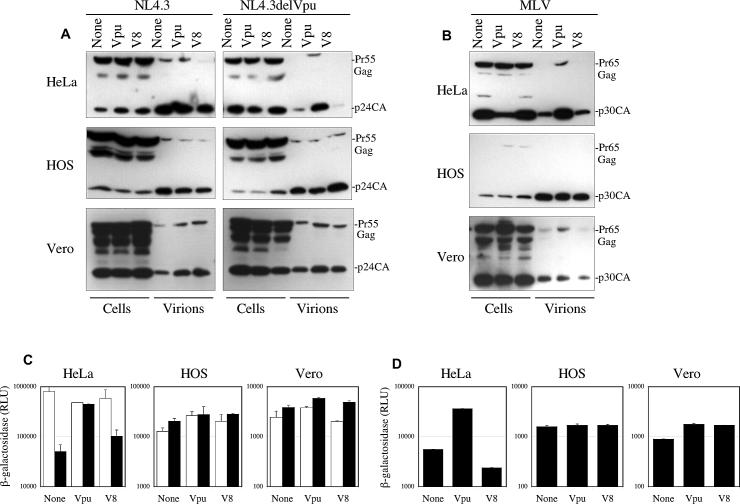
Cell Type–Dependent Effects of Vpu on Retroviral Particle ReleaseHuman HeLa and HOS cells, together with AGM Vero cells, were transfected with HIV-1 NL4.3 and NL4.3delVpu proviral plasmids, or an MLV Gag-Pol–expression vector, as indicated, in the presence of plasmids expressing either no Vpu (none), codon-optimized Vpu, or an inactive Vpu mutant containing a CD8 TM domain (V8).(A and B) Western blot analyses of cell and virion lysates, probed using antibodies to HIV-1 (A) or MLV CA (B).(C and D) Results of chemiluminsecent β-galactosidase assays following inoculation of HeLa-TZM indicator cells with supernatants derived from HeLa, HOS, or Vero cells transfected with NL4.3 (white bars) or NL4.3delVpu (black bars) proviral plasmids (C) or plasmids expressing MLV Gag-Pol, a packageable HIV-1 Tat–expression vector, and VSV-G (D). Vpu and control (GFP)–expression plasmids were included, as indicated, and results plotted as relative light units (RLU) ± standard deviation of the mean.